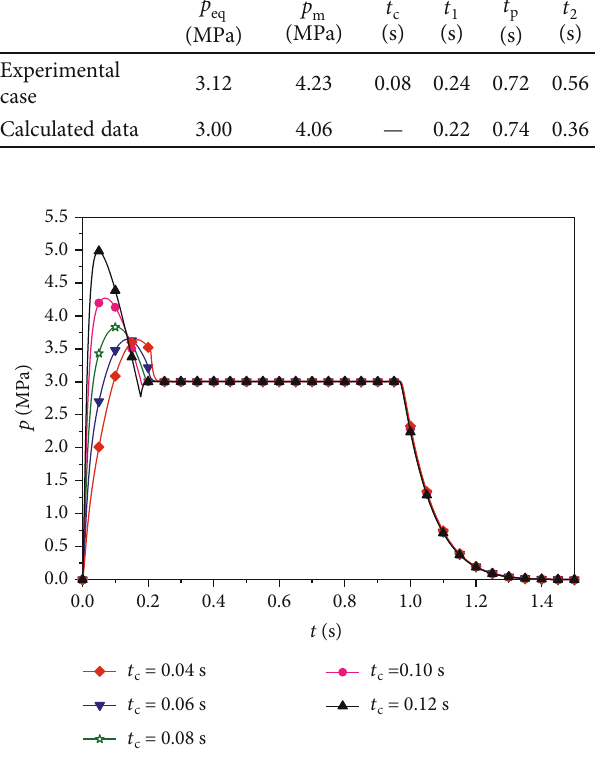
Figure 9: The pressure evolution in the combustor for di ff erent ignition delay